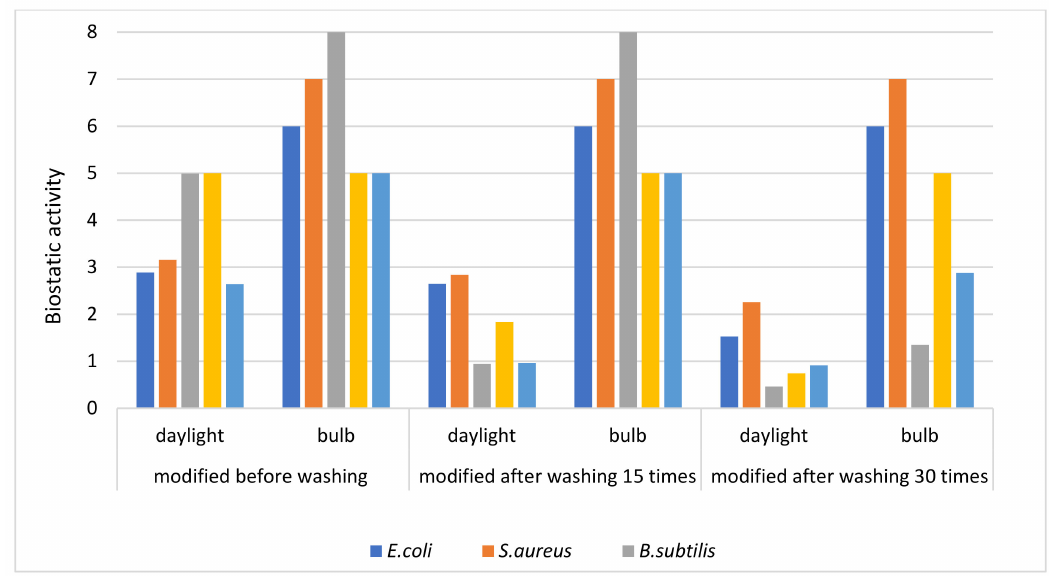
Figure 6. Antimicrobial activity of tested modified cotton samples/before and after washing (15/30 cycles) incubated in different lighting conditions. Biostatic activity < 1 low; 1–3 medium; >3